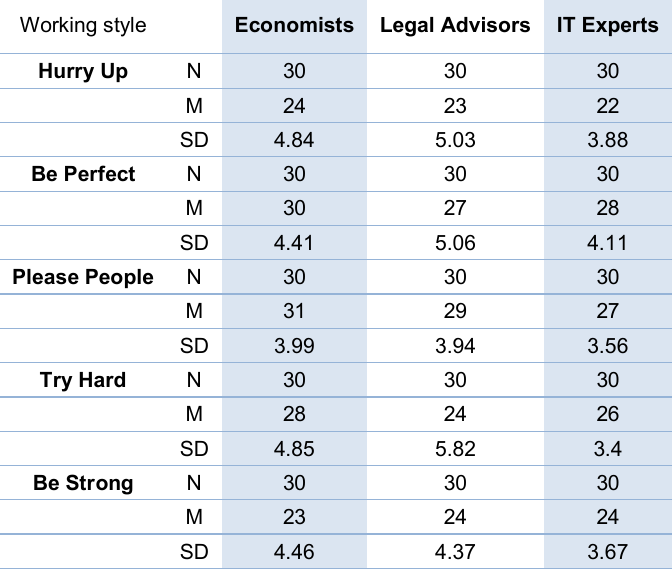
Table 2. Main descriptive statistics of the variables Working styles and Professions Working style